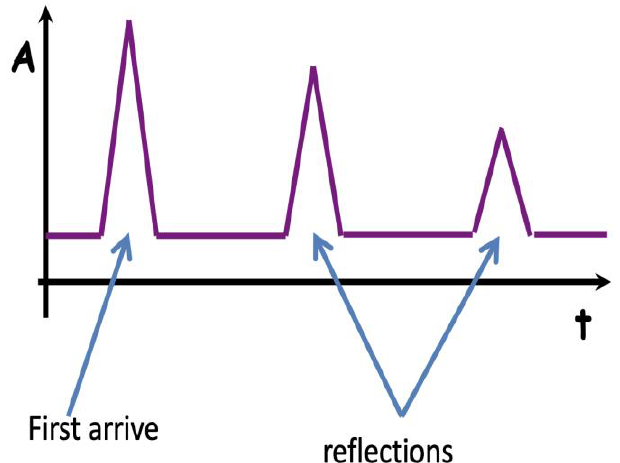
Figure 3. Expected signal, A is the amplitude as a function of the time t: First arrive of the wave and the n reflection (the wave travels two times the sample thickness).